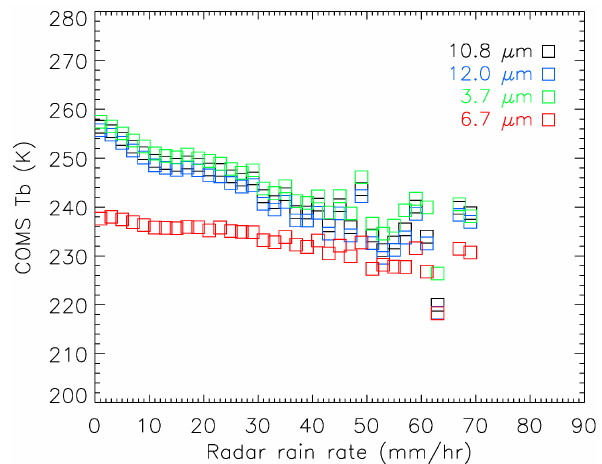
Figure 3. Mean relationship between the COMS brightness tem- perature ( T b ) and the Jindo radar rain rate. Channels at 10.8, 12.0, 3.7, and 6.7µm are indicated by black, blue, green, and red squares,